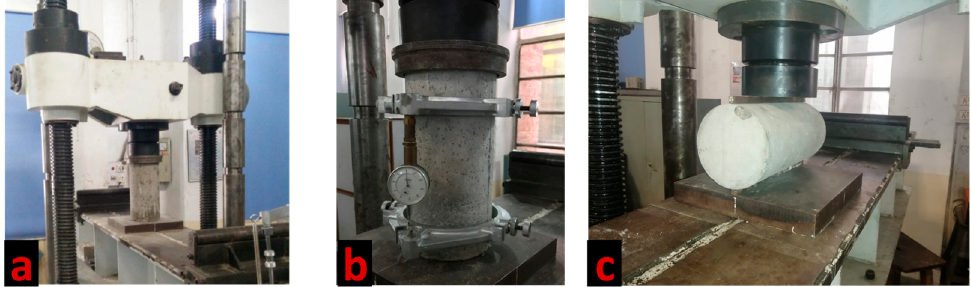
Figure 5. Experimental setup for mechanical testing ( a ) compressive strength test, ( b ) modulus of elasticity test, ( c ) split cylinder strength test setup.